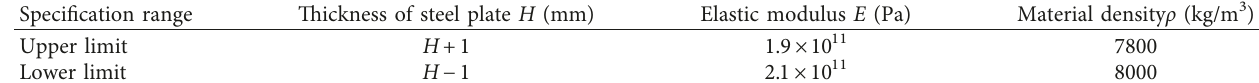
Table 3: Allowable range of material ex-factory performance.